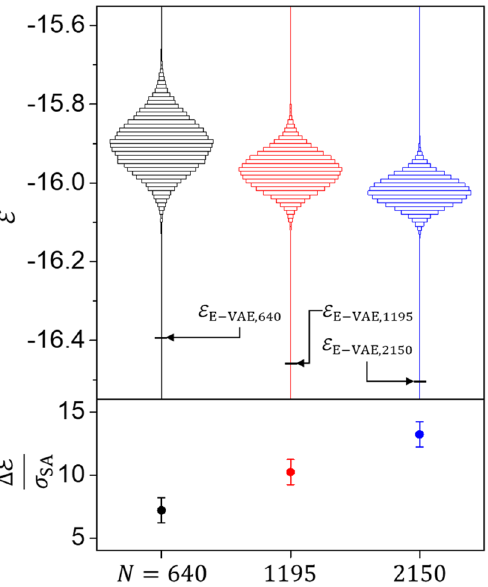
Figure 4. Estimating the ground states using E-VAE for systems of different sizes. Comparison between results of simulated annealing and our method using the E-VAE model for the N = 640 , 1195, and 2150 cases. ε histograms are calculated using the training datasets, and ε E − VAE, N s indicate the energy density values of the spin states obtained from the trained E-VAE models for each of the N cases. �ε/σ SA represents (µ SA − ε E − VAE )/σ SA , where µ SA and σ SA are the mean and standard deviation values of ε